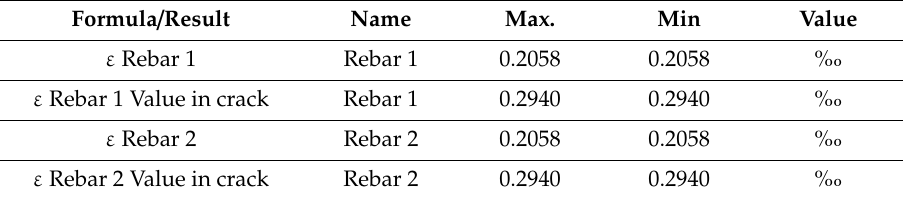
Table 8. Deformation of the rebars 1 and 2 for a moment of 127.88 mkN by FAGUS. Formula / Result